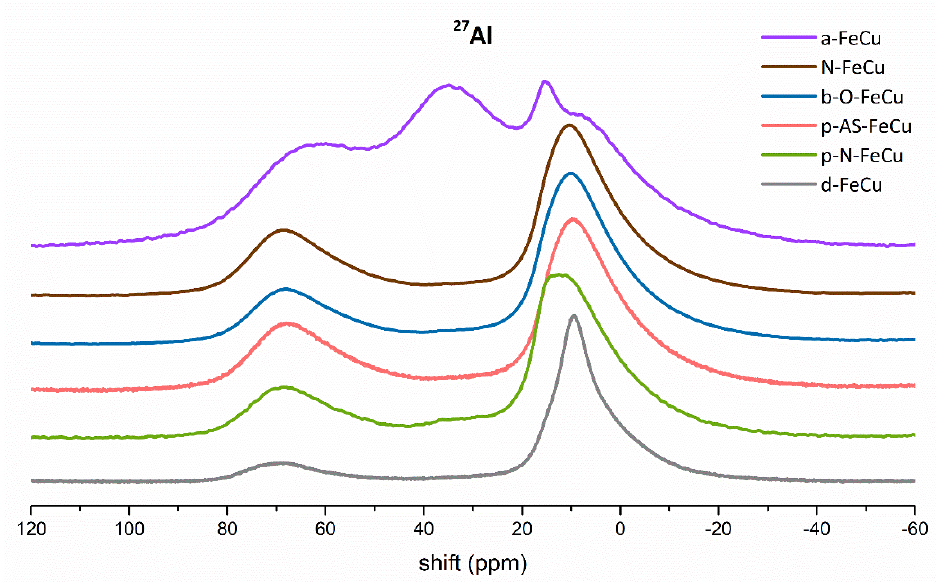
Figure 8. 27 Al NMR spectra of FeCu samples.